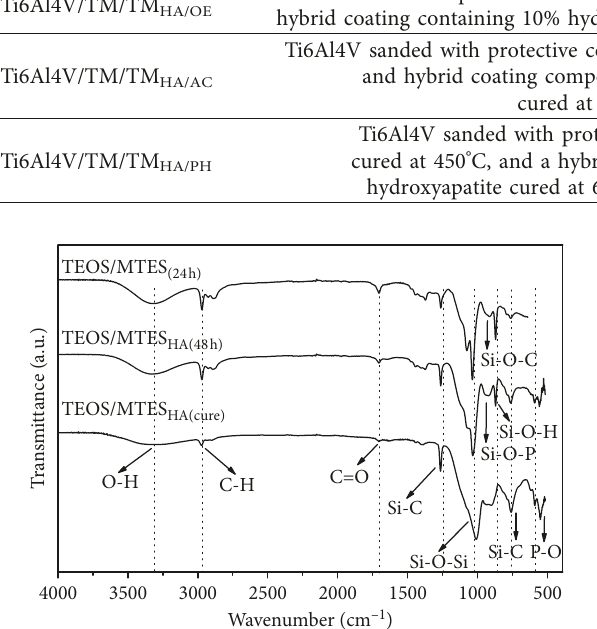
Figure 2: FTIR of the TEOS/MTES solution hydrolyzed for 24h with the addition of the hydroxyapatite particles after 24h and after condensation and cure